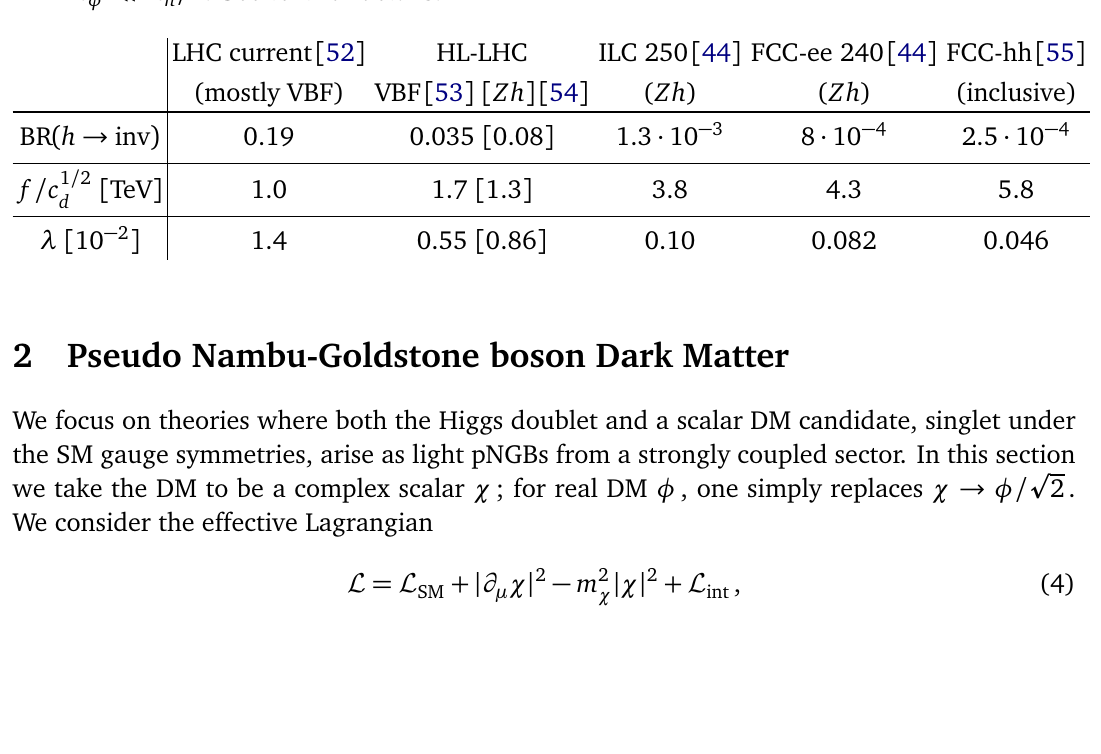
Figure 2: Projected 95% CL constraints on the Higgs portal couplings at future collid- ers. Left: derivative Higgs portal. To remain within the regime of validity of the EFT / 2 we only retain events with M φφ < g ∗ f / c 1 , where g ∗ is set to 4 π . This requirement d / 2 cannot be satisfied in the gray region 2 m φ > g ∗ f / c 1 . The excluded region is the d one enclosed by each line. All limits are derived from VBF. Right: marginal Higgs portal. The excluded region is the one above each line. Solid lines correspond to VBF processes: in addition to the benchmarks in Table 1, we show ILC 1 TeV with 1 ab − 1 (solid red). Dashed lines correspond to Zh production from Ref. [ 44 ] : ILC 500 GeV with 1 ab − 1 (dashed red) and FCC-ee at 350 GeV and 2.5 ab − 1 (dashed (cid:112) y 2 yellow). The dotted line labeled “Naturalness” corresponds to λ = 4 N , namely c t two degenerate scalar top partners. In both panels, for the HL-LHC we also show a gray band whose weaker limit boundary corresponds to adding a 1% systematic uncertainty on the background. Table 3: 95% CL exclusion limits on the coefficients of the derivative and marginal Higgs portal operators, obtained from on-shell invisible Higgs decays, assuming / 2. See text for m φ (cid:28) m h